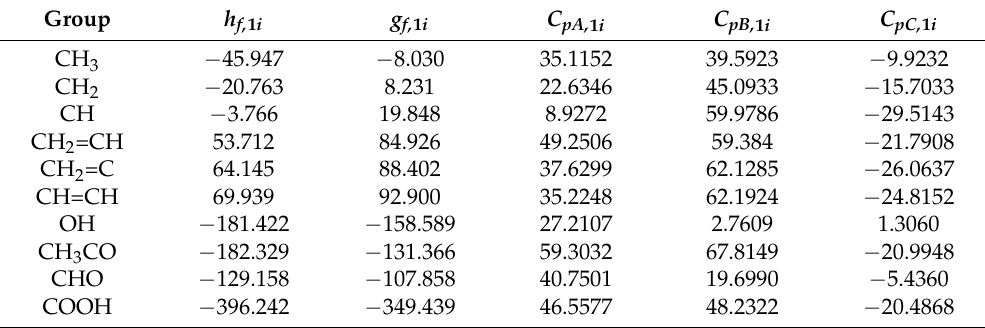
Table A2. First-order group contributions of the Constantinou-Gani method